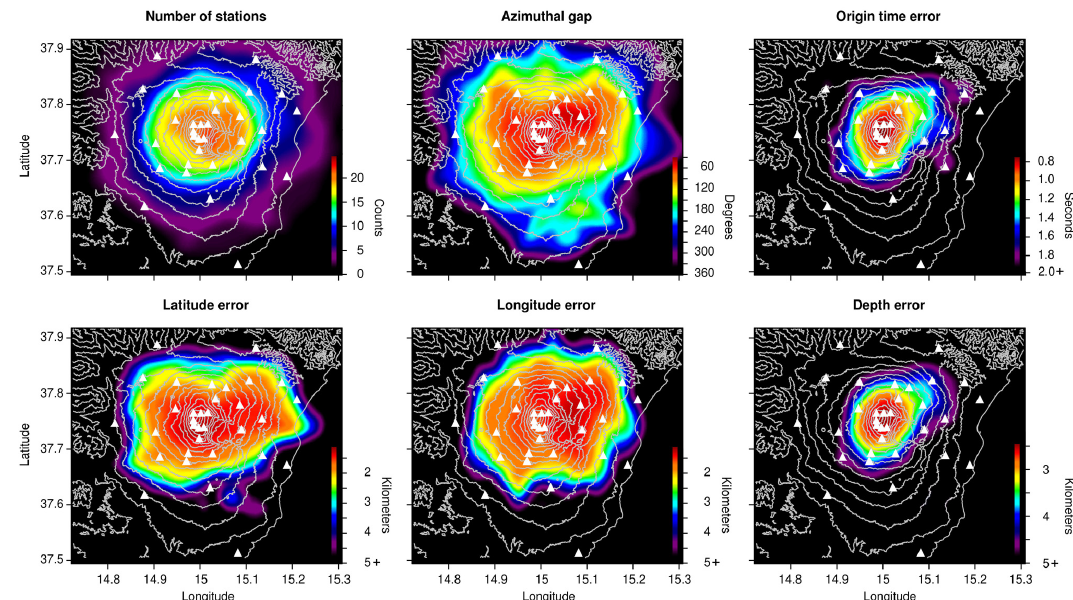
Fig. 5. SNES maps for ESN at M L 1.5, hypocentral depth of 5km and confidence level of 95%.